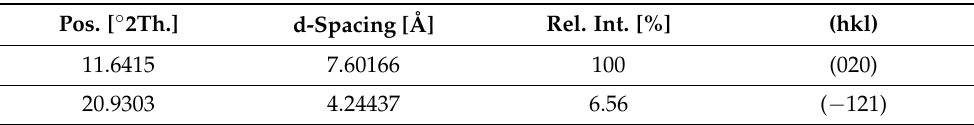
Table 3. Values of d-spacing, 2 theta, relative intensity and Miller indices (hkl) of the sample as extracted from the X-ray data